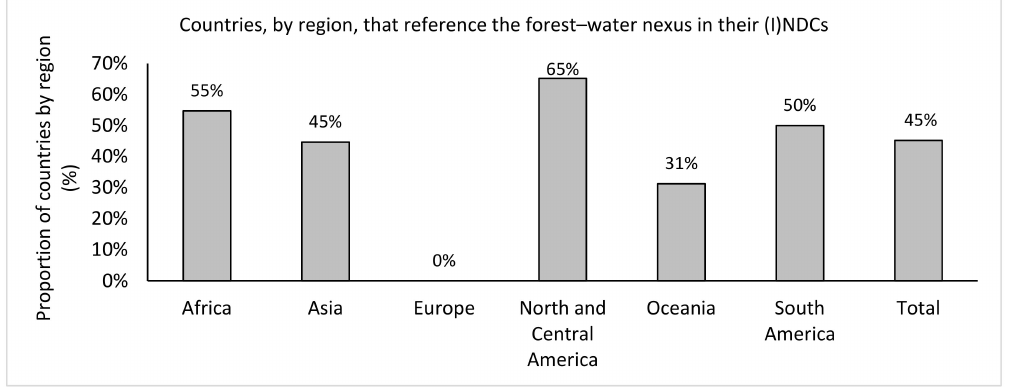
Figure 3. Proportion of countries by region that reference the forest–water nexus in their (I)NDCs. Table 3. Proportion of (I)NDC keywords related to the forest–water nexus by region. FAO Region /